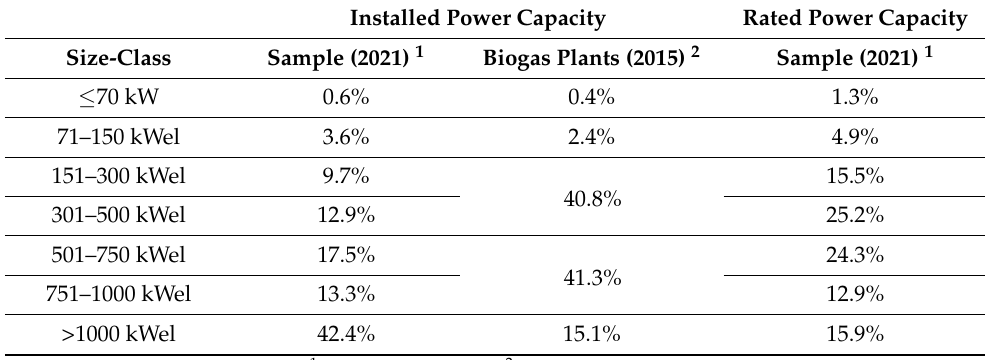
Table 1. Size distribution according to the power generation capacity.